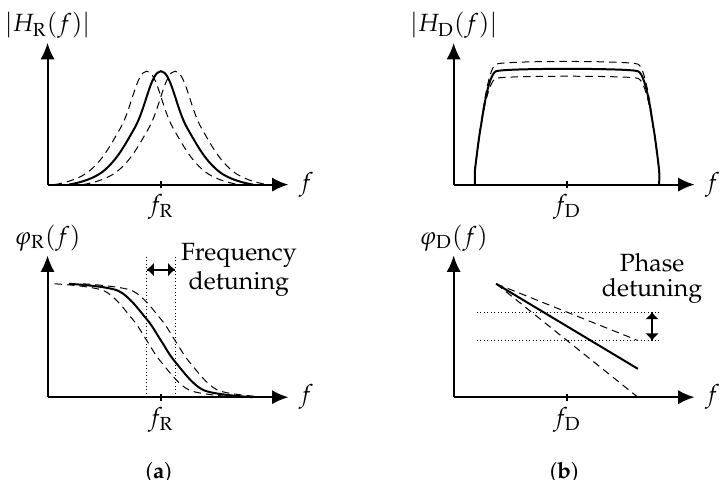
Figure 2. General impact of a change in the physical quantity to be detected on the frequency response of a resonant sensor ( a ) and on a delay line sensor ( b ). Changes in magnitude are not discussed in this article because of amplitude compression in closed-loop readout systems. ( a ) Resonant sensor; ( b ) delay line sensor. Table 1. Relations between open-loop and closed-loop sensitivities for resonant sensors and delay line